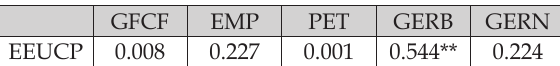
Table 4. Correlations between the expenditures of EU Cohesion policy and development indicators across CEE